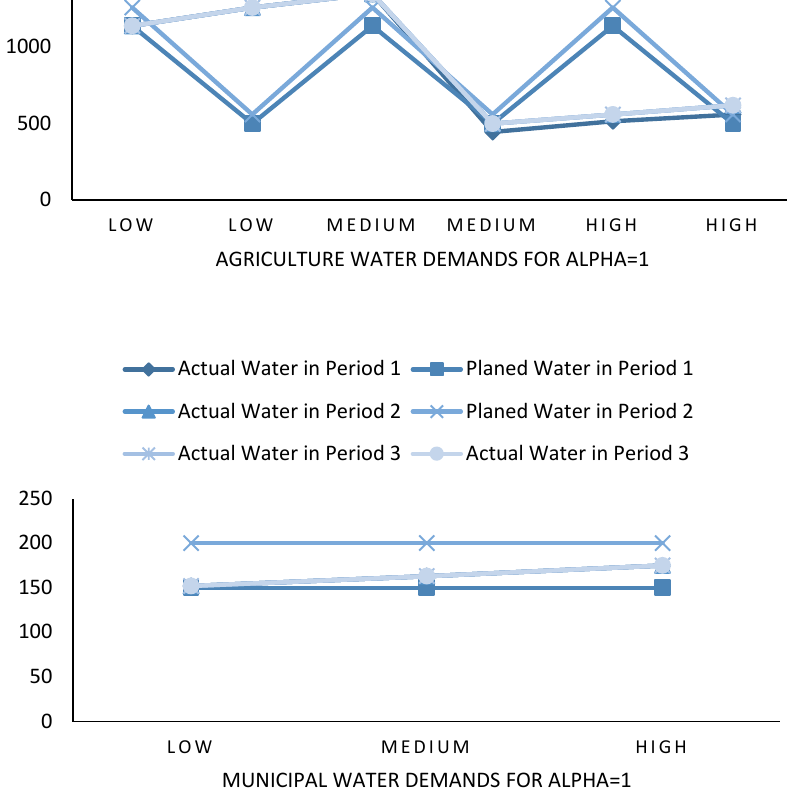
Figure 8. Comparison of actual water and planned water under acceptance degrees.